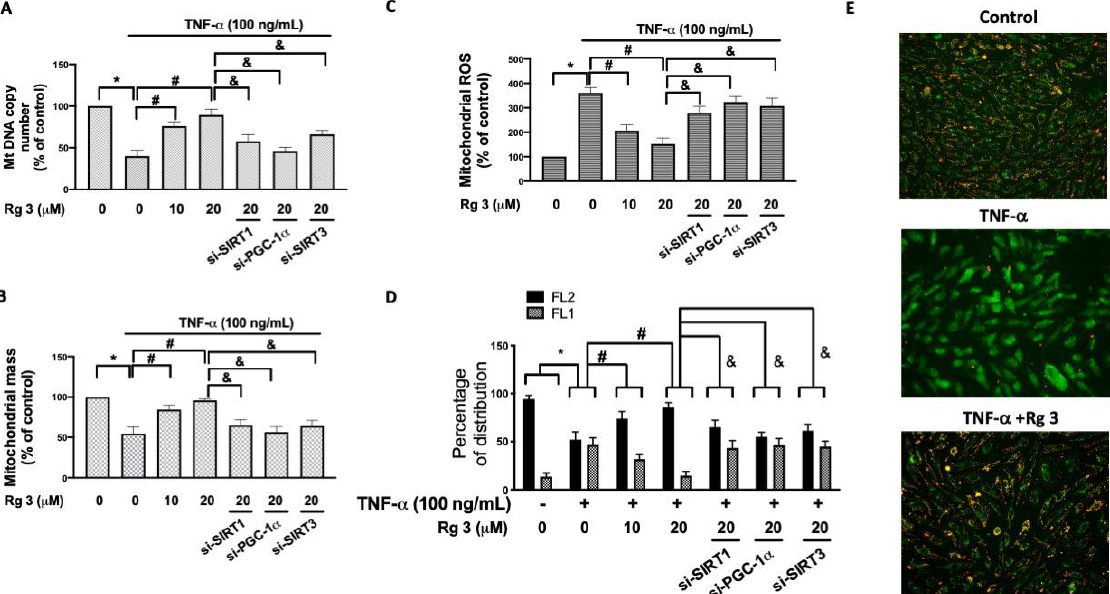
Figure 3. Rg3 up-regulates mitochondrial biogenesis, reduces ROS, and maintains mitochondrial function under TNF- α stimulation. The mitochondrial DNA copy number ( A ) and mitochondrial mass ( B ) were examined after administration of TNF- α for 24 h. In some cases, cells were transfected with siRNAs 48 h before treatment with Rg3. Dihydroethidium (DHE) was used for the investigation of mitochondrial ROS ( C ). Percentage of cells expressing JC-1 aggregates (red fluorescence; FL2) and JC-1 monomers (green fluorescence; FL1) were assessed using flow cytometry ( D ) or a fluorescence microscope ( E ). (* indicating p < 0.05 compared with the control group; # indicating p < 0.05 compared to TNF- α -stimulated cells; & indicating p < 0.05 compared to TNF- α plus Rg3 cells).